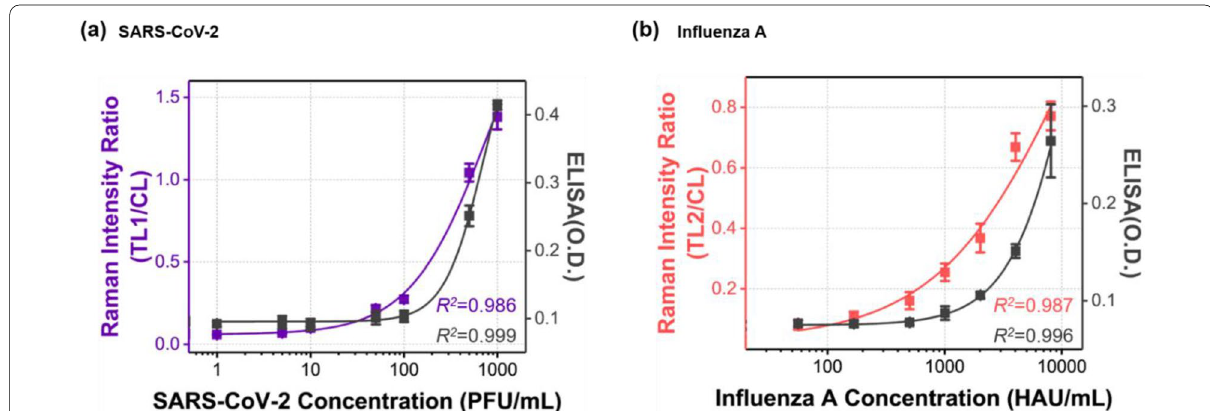
Fig. 4 Comparison of calibration curves for a SARS-CoV-2 and b influenza A virus, determined by the measurement results of ELISA and dual-mode SERS-LFA. Each calibration curve was determined using a four-parameter sigmoidal fitting equation (black: ELISA, purple and red: SERS-LFA). The y- axis represents the optical density for ELISA and the Raman scattering intensity ratio of the test and control lines for